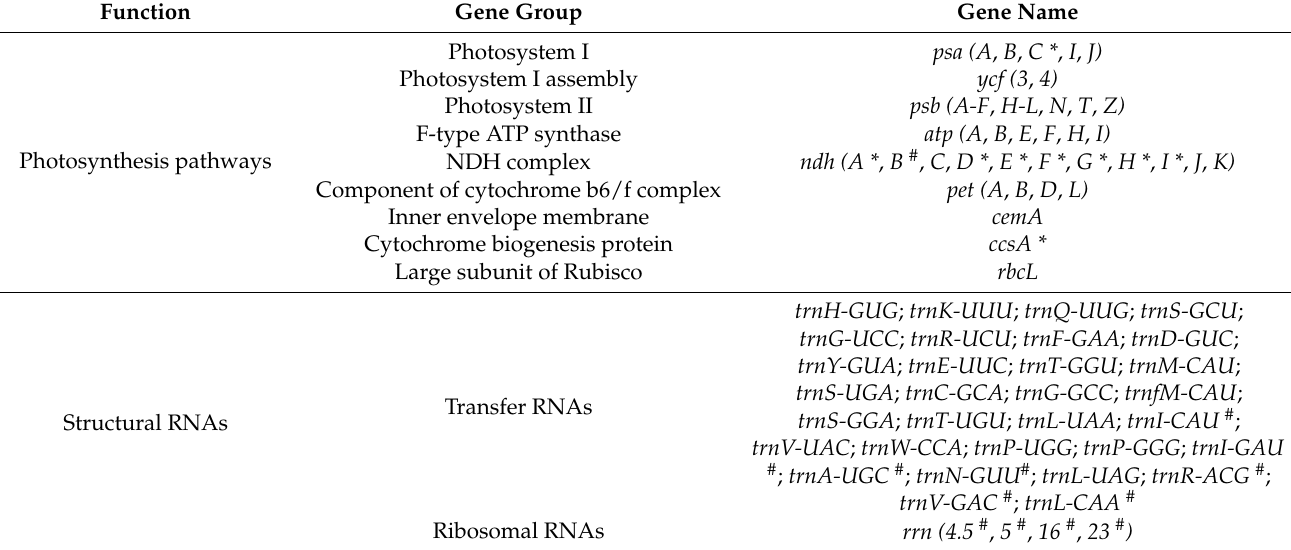
Table 4. List of genes encoded by 13 cp